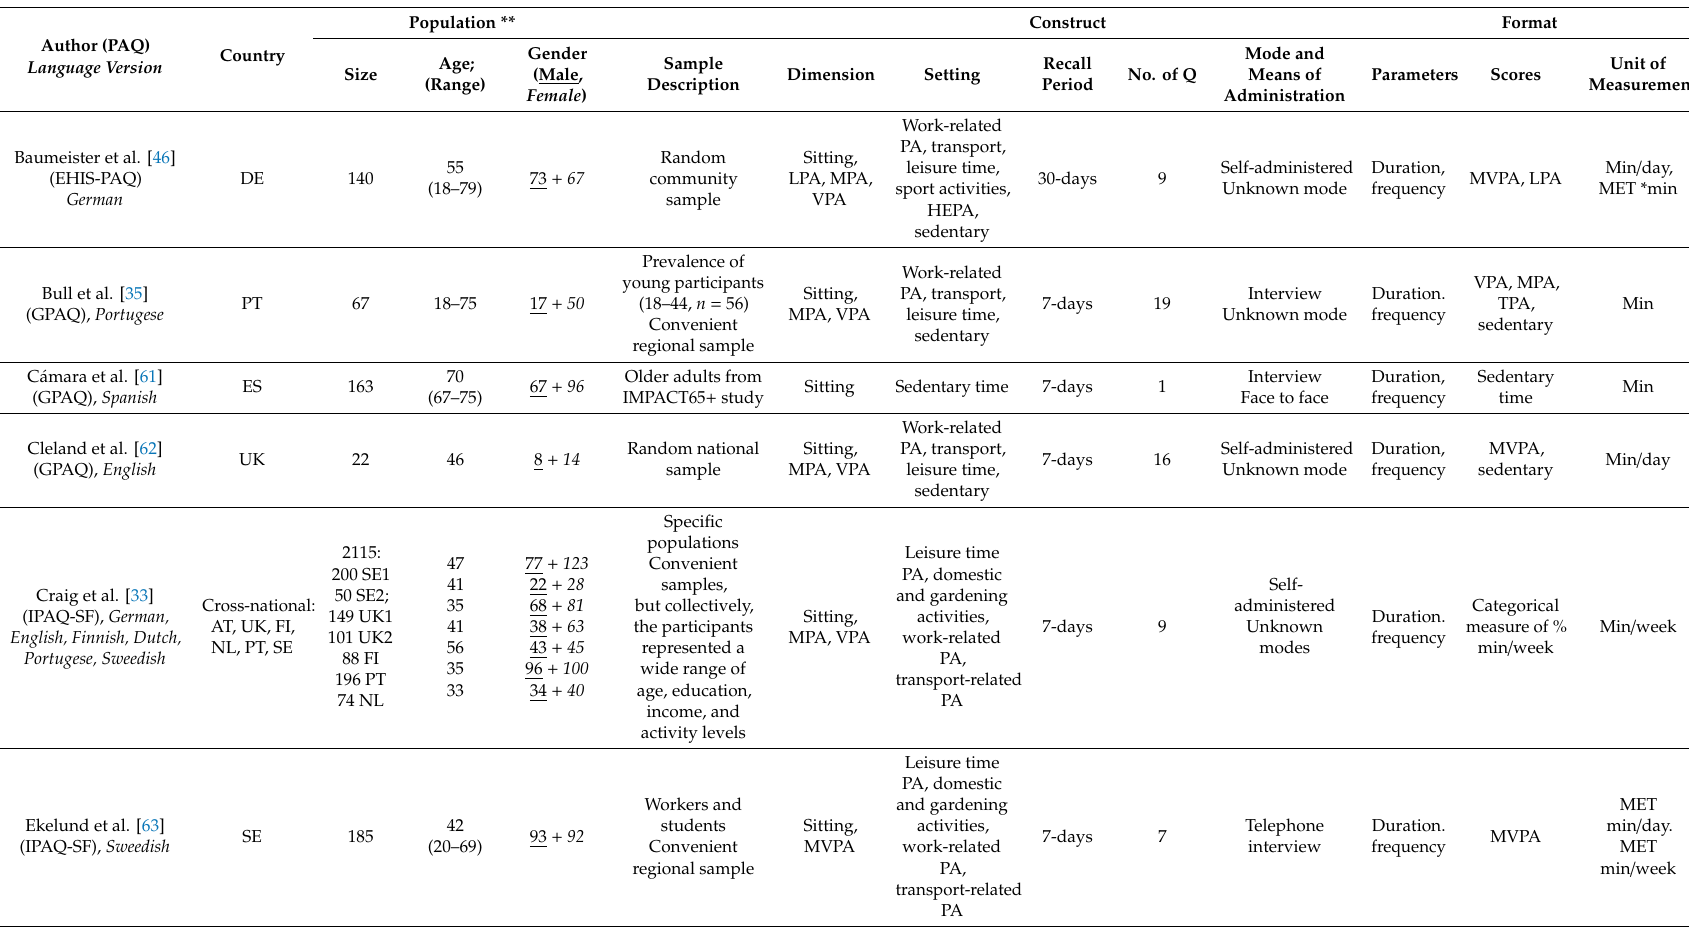
Table 1. General characteristics of selected studies of PAQs across the